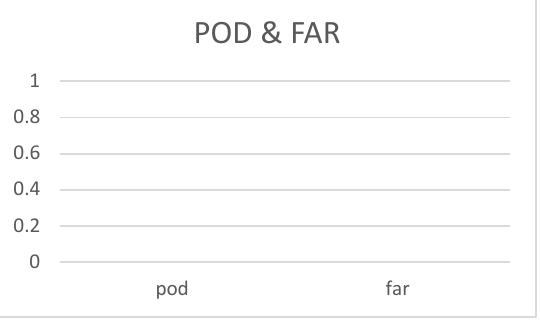
Figure 3. POD and FAR of all cases.